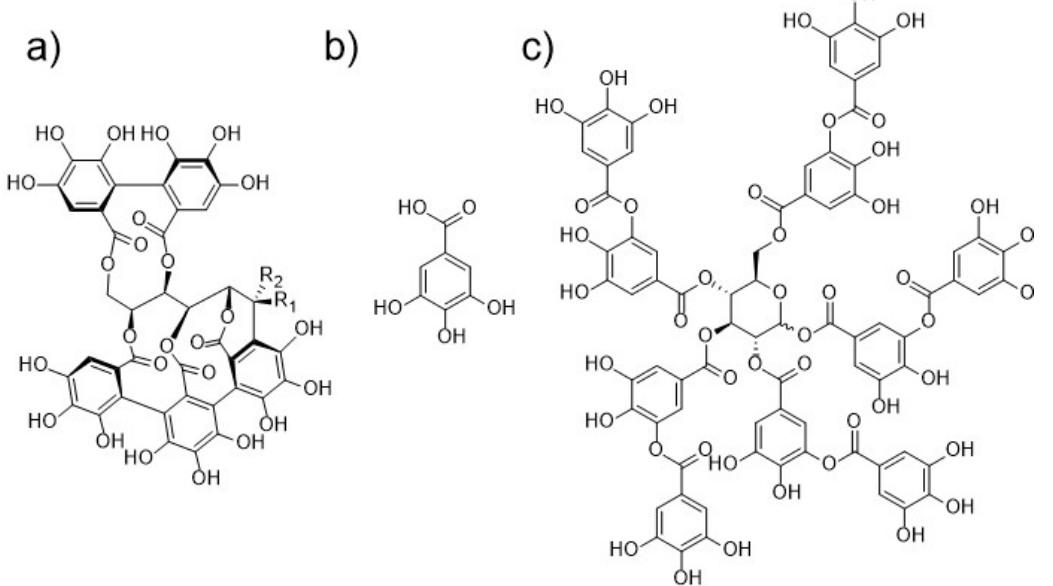
Figure 1. Chemical structures of ( a ) diastereoisomers castalagin (R 1 = H, R 2 = OH) and vescalagin (R 1 = OH, R 2 = H), ( b ) gallic acid, ( c ) decagalloylglucose, one of the gallotannins typically present in tannic acid.